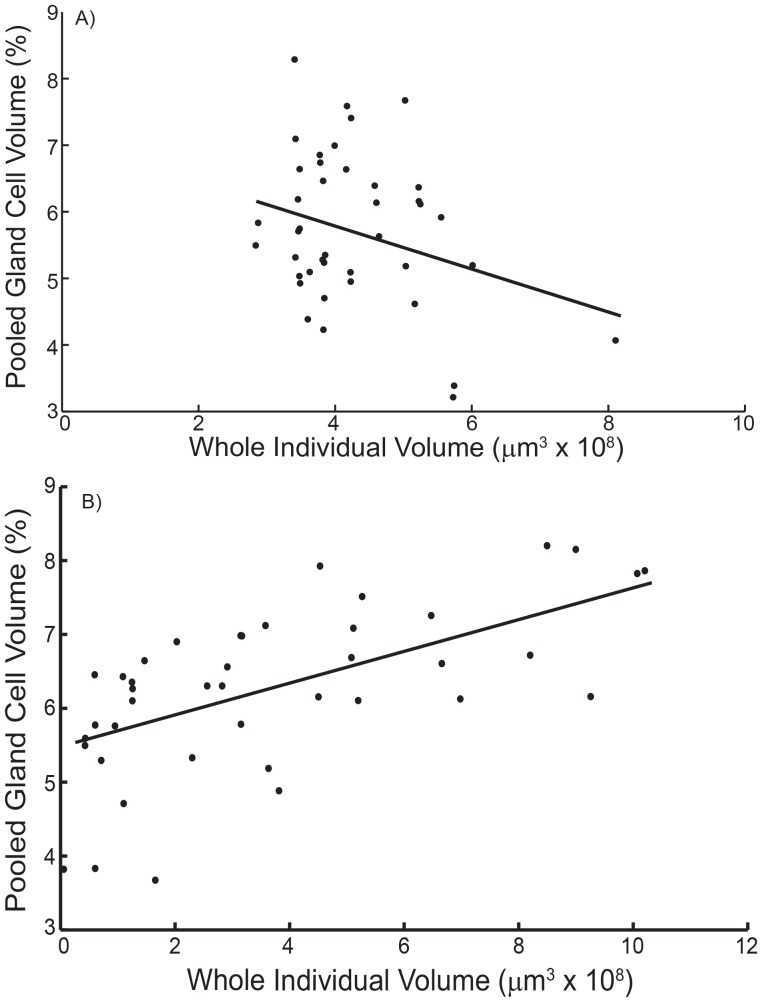
Model simulations of growth (whole individual – total volume) and defence levels (whole individual – pooled gland cell volume) under low (A) and moderate (B) light (n = 40 random individuals).(A) Under low light (10 µE) a negative correlation across individuals occurs with decreasing pooled gland cell volume in larger (more frequently branched) individuals. (B) Under moderate light (35 µE) a positive correlation is driven by greater variation in cell division between individuals producing individuals of different sizes, independent of branch frequency. Significant correlations are shown (P<0.05).